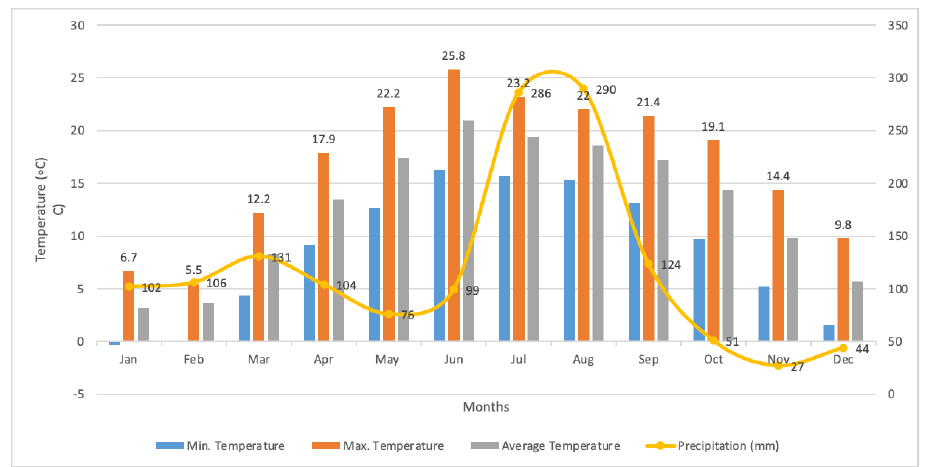
Figure 1. Annual temperature and precipitation data for Murree, Pakistan, recorded for the year 2018.